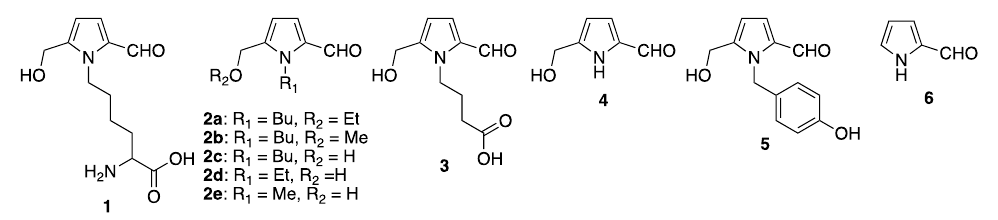
Figure 1. Structures of Py-2-Cs 1 – 6 .